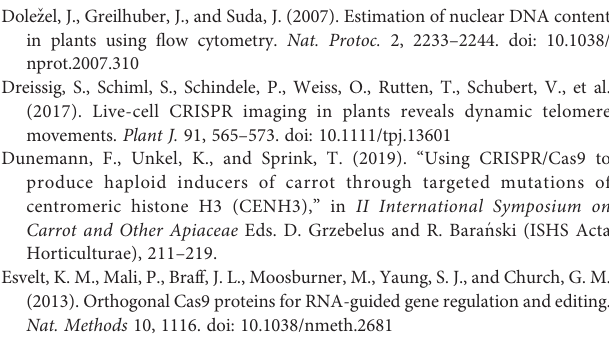
FIGURE SUPPLEMENT 1 | Different components of the aptamer-based labeling method: 1) dCas9 from S. pyogenes , 2) MS2 or PP7 aptamers (here only MS2 is shown) which are integrated into sgRNA scaffold. 3) RNA binding protein (tdMCP or tdPCP) fused to a fl uorescent protein (mRuby) which recognizes aptamers. FIGURE SUPPLEMENT 2 | Changing the sgRNA scaffold with A/U fl ip (in red) and insertion of an extension (in green). FIGURE SUPPLEMENT 3 | Speci fi city control test by ImmunoFISH for the activity of the inducible XVE promoter. (A) Isolated nuclei after treatment of leaves with b -estradiol show telomeric signals. Co-localization of dCas9:2xMS2:GFP and FISH signals show that the observed signals are telomeric speci fi c. (B) Nuclei isolated from b -estradiol-untreated leaves show a uniform labeling of nuclei. FIGURE SUPPLEMENT 4 | Real time expression of dCas9 expressed by ubiquitin and XVE promoters. dCas9 expression is much lower when it is driven by inducibleXVEpromoter compared toubiquitin from parsley.Error barsare standard deviation. FIGURE SUPPLEMENT 5 | Selected nuclei of A. thaliana stably transformed with a centromere-speci fi c dCas9:2xMS2:GFP construct exhibiting dot-like signals. (A, B) Application of the centromere-speci fi c protospacer 1 and 2, respectively. The number of signals was higher than expected. FIGURE SUPPLEMENT 6 | Immunostaining of dCas9 protein in isolated nuclei from leaf material of stably transformed Arabidopsis plants with dCas9:2xMS2: GFP targeting centromeric regions. (A) Immunostaining of dCas9 in stably transformed Arabidopsis plants showed the dCas9 is not degraded. (B) Immunostaining of isolated leaf nuclei from wild type Arabidopsis leaf nuclei did not result in signals which shows that the applied antibody against dCas9 is working speci fi